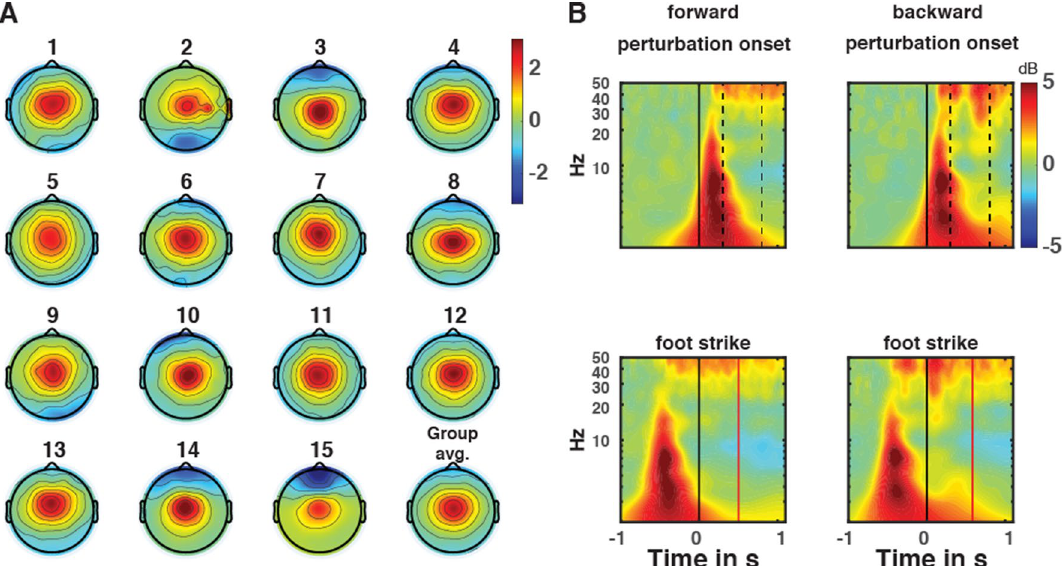
Figure 3. Characteristics of midfrontal GED component data. ( A ) Participant-specific scalp topographies of the spatial filter with the largest eigenvalue and a midfrontal topography (normalized scale). The group average (Group avg.) scalp topography is presented in the bottom right figure. ( B ) Group averaged time–frequency results. Top row illustrates forward and backward time–frequency analysis of perturbation time locked EEG data, with the vertical solid line indicating perturbation onset. The vertical dashed lines indicate the start of platform constant velocity (0.3 s) and the end of the constant velocity phase (0.8 s). Bottom row illustrates time– frequency analysis of foot strike event time locked EEG data. The black vertical line at 0 s indicates the moment of foot strike and the vertical red line represents the average end of platform motion relative to foot strike in the forward or backward direction. Figures were created with the EEGlab